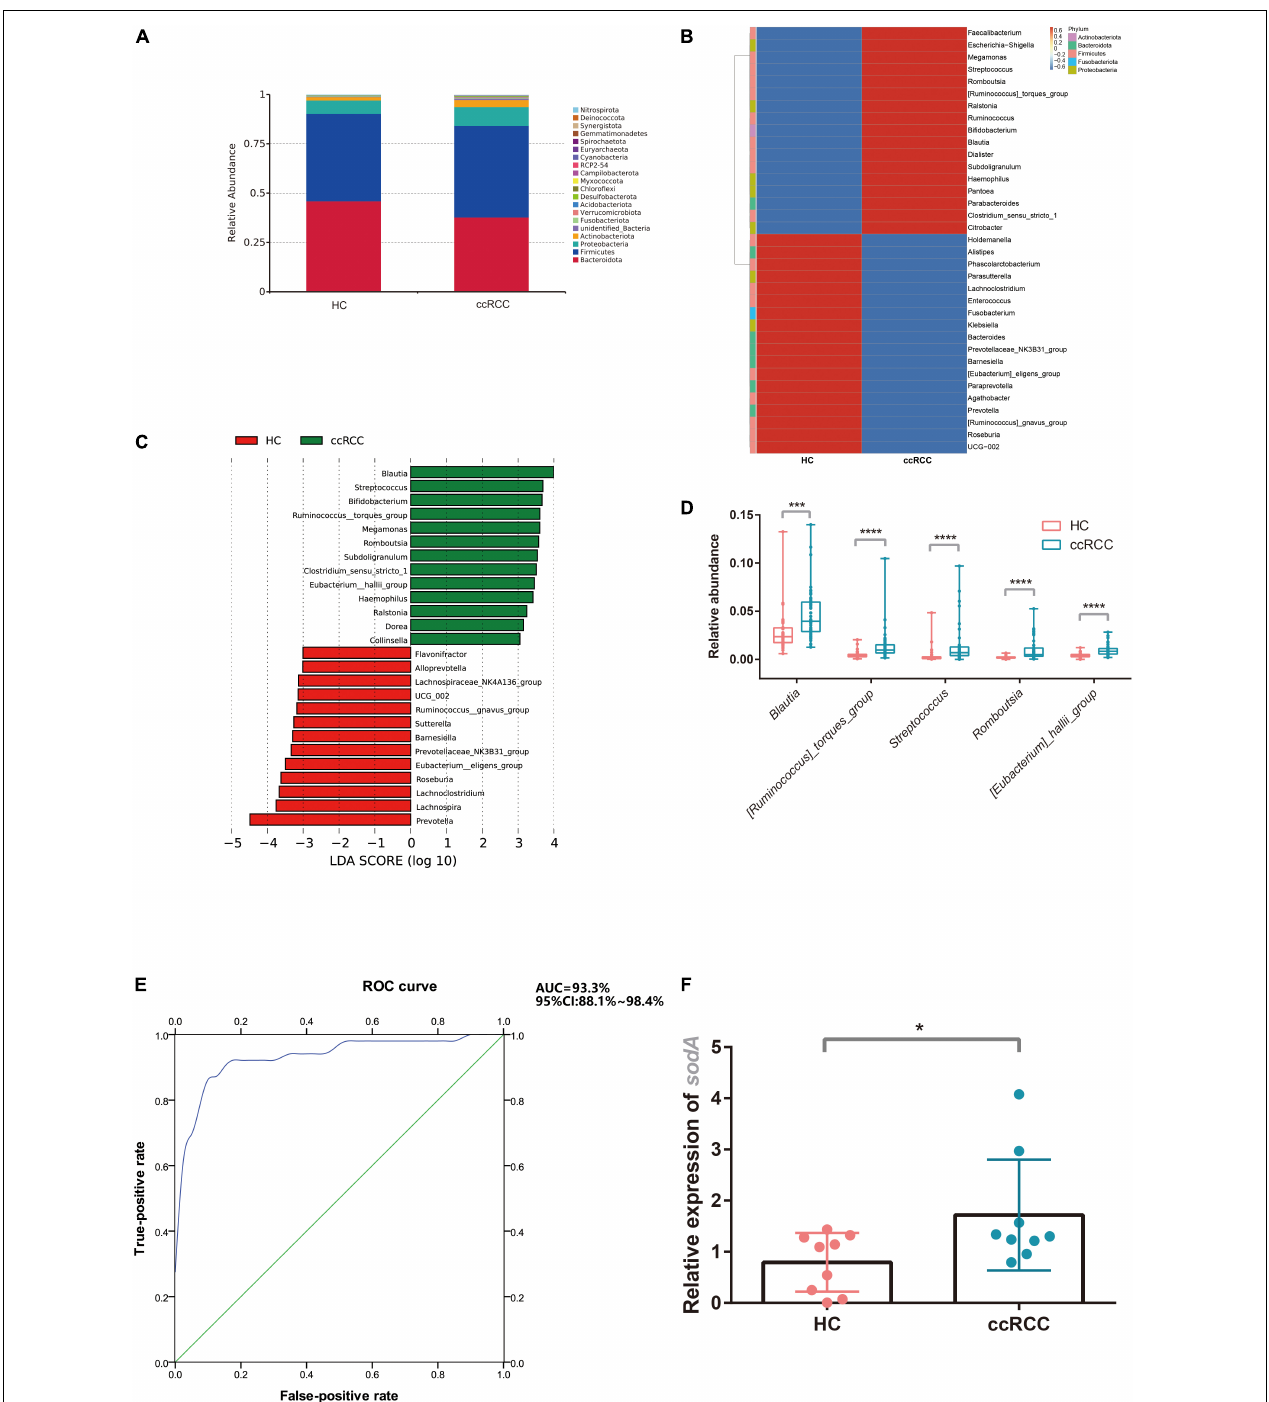
FIGURE 3 | Characteristic gut microbiota in ccRCC and HC groups. The gut microbiota composition at phylum (A) and genus levels (B) between groups was analyzed. (C) LEfSe analysis indicated group-associated microbiota at the genus level. Bars on the right of zero represent microbiota enriched in the ccRCC group, whereas bars left of zero represent microbiota enriched in the HC group (LDA > 3). (D) Five representative genera “ Blautia, Streptococcus, [Ruminococcus]_torques_group, Romboutsia, [Eubacterium]_hallii_group ” were analyzed (E) to build a receiver operating characteristic curve of a “five-genera” model predicting RCC risk. (F) S. lutetiensis levels were determined using qPCR targeting sodA . Results are presented as the mean ± SD. Statistical evaluations were performed using the Kruskal–Wallis test followed by Dunn’s multiple comparisons test. * p < 0.05, *** p < 0.001, **** p < 0.0001. ccRCC, clear cell renal cell carcinoma; HC, healthy control; LEfSe, linear discriminant analysis effect size; LDA, linear discriminant analysis; PCoA, principal coordinates analysis; sodA , superoxide dismutase A; SD, standard deviation.